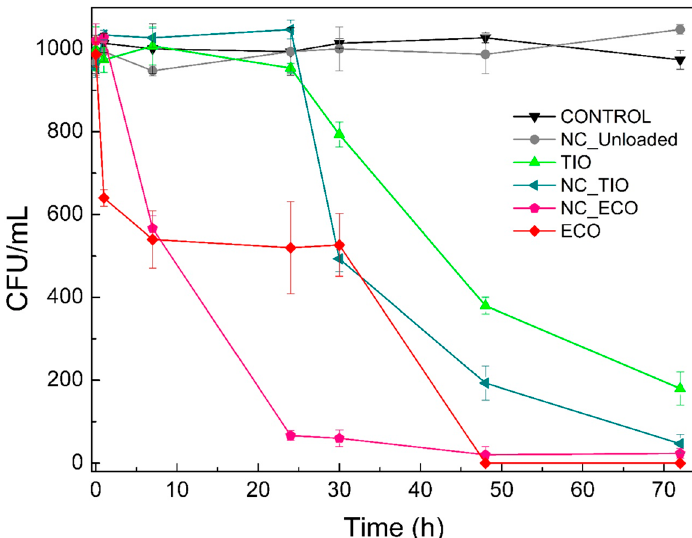
Figure 8. C. albicans surviving at each time point when treated with different formulations. Data shown are means ± SD ( n = 3).